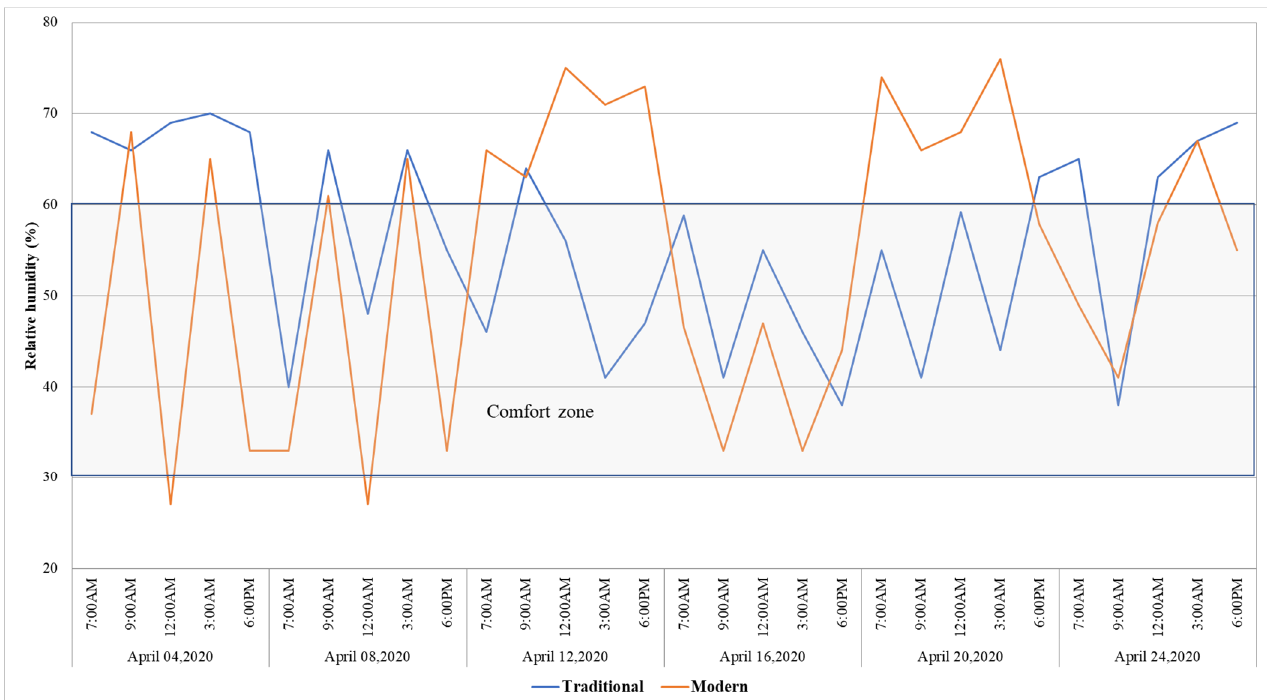
26 of 35 Figure 26. Indoor thermal comfort evaluation from April 2020.